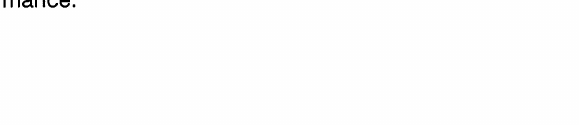
FIG. 1. Recall of either the first or last name (A), or both the first and last name (8) improved across weeks of memory training for the patients with dementia. Age matched controls had learned approximately all eight first and last names of group participants by the second week of memory training and maintained a high level of perfor